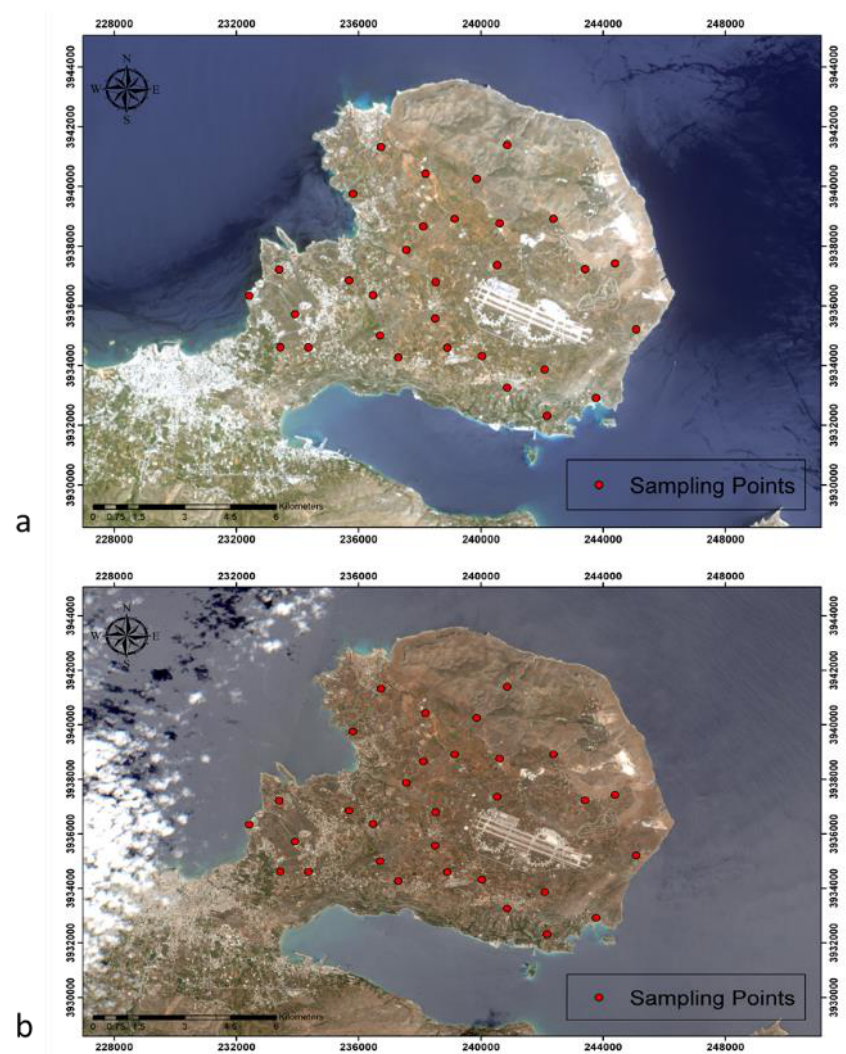
Figure 2. Landsat 8 (up) and Sentinel-2 (down) natural color composites [(Landsat 8 RGB: 432, 30 m spatial resolution), (Sentinel-2 RGB: 432, 10 m spatial resolution)] and corresponding sampling points allocation. RGB= red, green, blue.